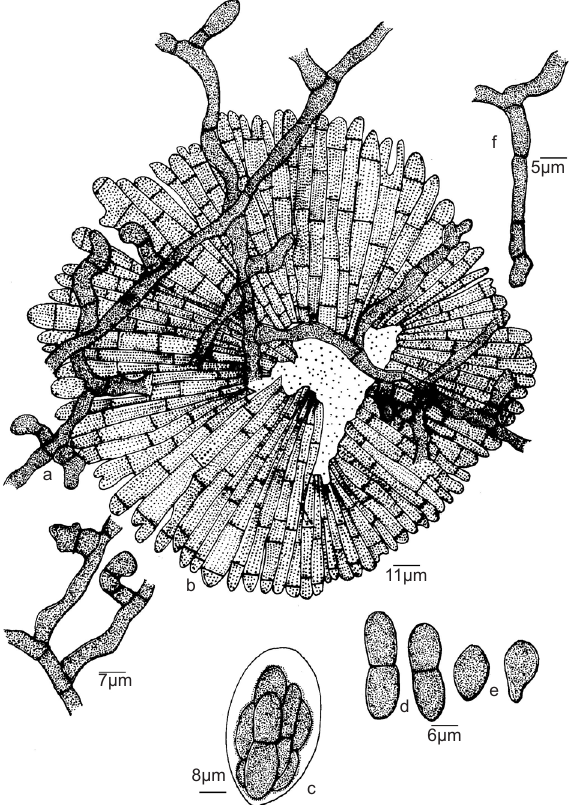
Figure 2. Asterina myristicae sp. nov. a - Appressoriate mycelium; b - Thyriothecium; c - Ascus; d - Ascospores; e -